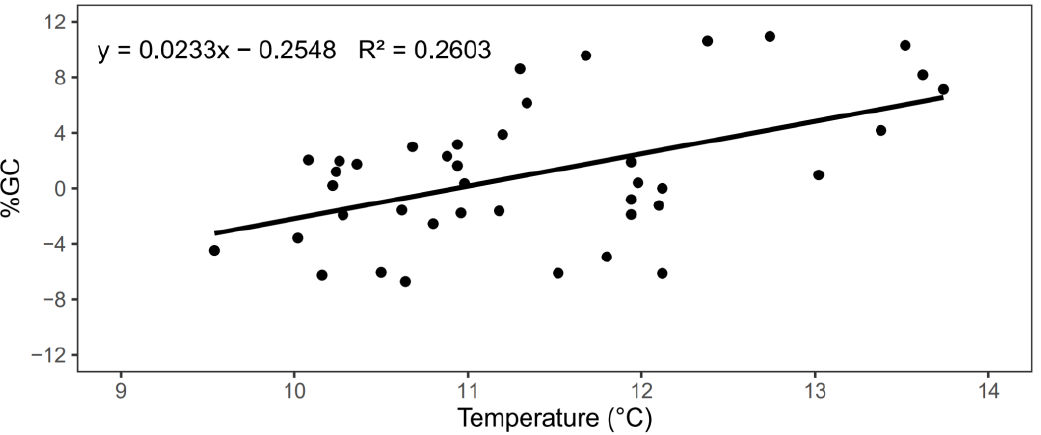
Figure 6. Linear regression between the regional %GC and the 5-year moving-average air temperature in May from 1966 to 2006.